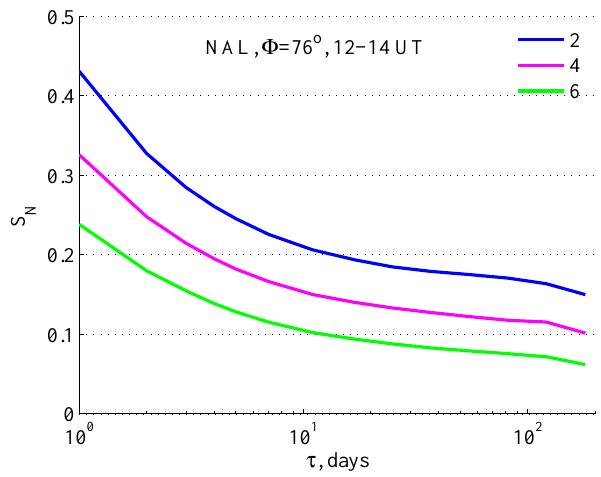
Fig. 10. Dependence of variance S N of the approximation (2) of σ(F,τ) , N = 2 , 4 , 6 on time of averaging τ for NAL station at after- noon time. Orders of the approximation are given with numbers at the